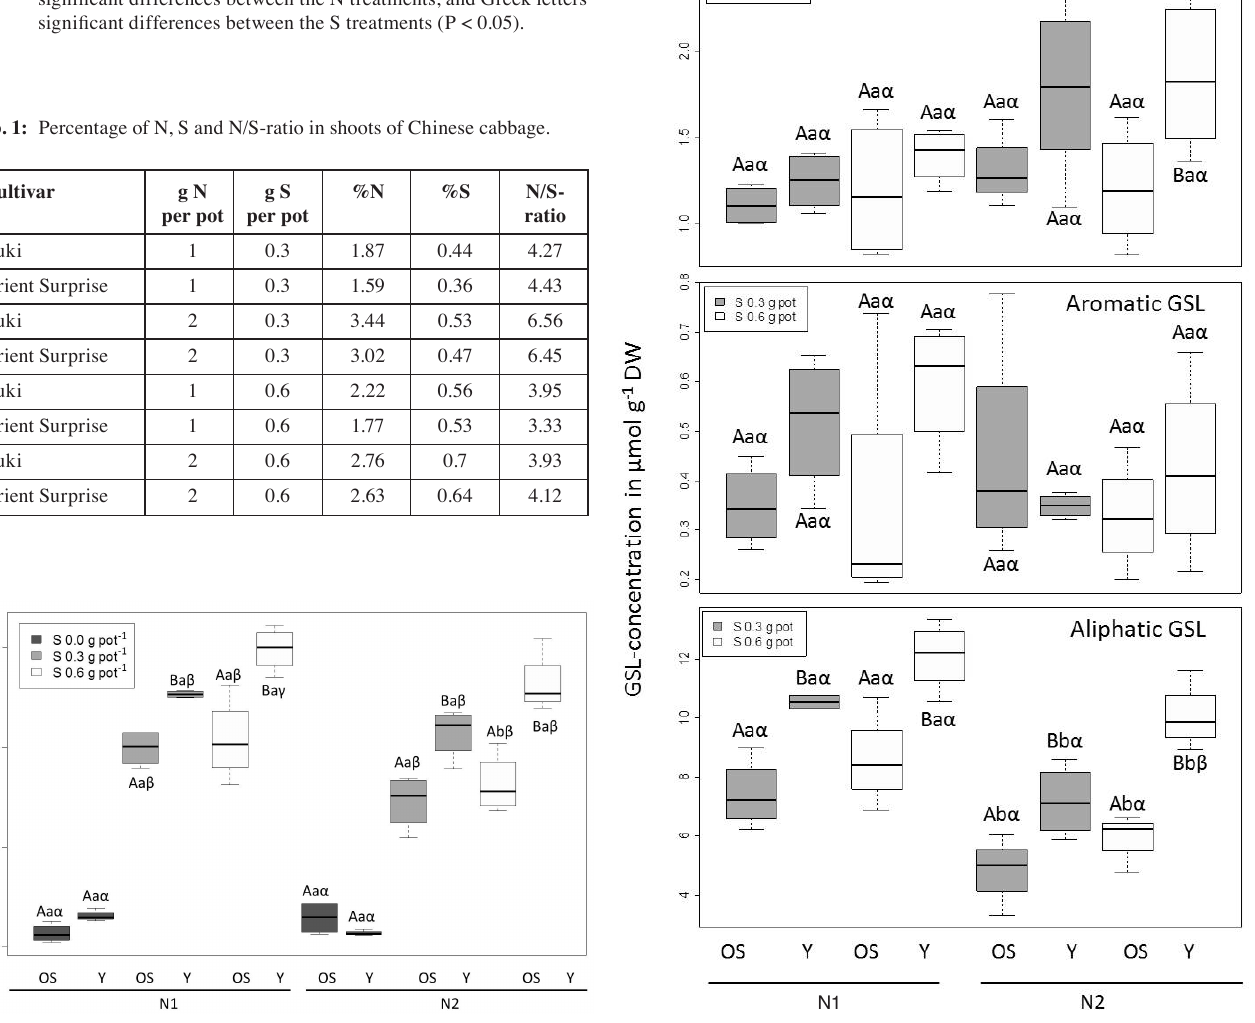
Fig. 3: Total GLS concentration in the cvs. orient Surprise (OS) and Yuki (Y) in dependency to the N (1.0 and 2.0 g pot -1 ) and S (0, 0.3 and 0.6 g pot -1 ) supply. N1, 1 g pot -1 ; N2, 2 g pot -1 . Uppercase letters represent significant differences between the cvs., lower case letters represent significant differences between the N treatments, and Greek letters significant differences between the S treatments (P < 0.05).